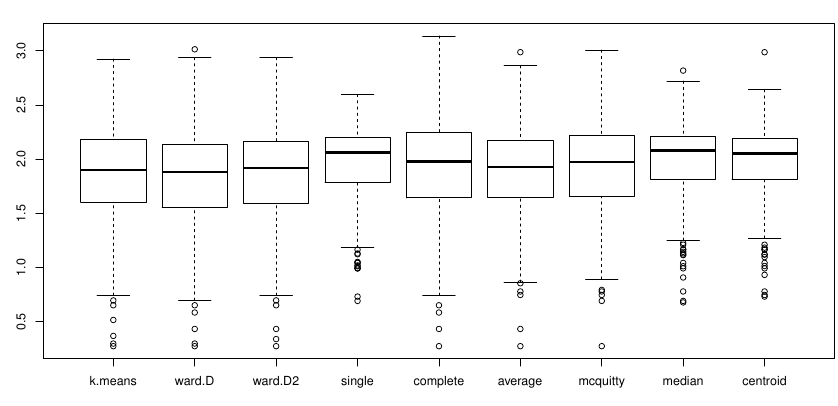
Figure 6. Box plots of simulated VIs using various clustering methods in the second stage of WNACut for γ 1 =